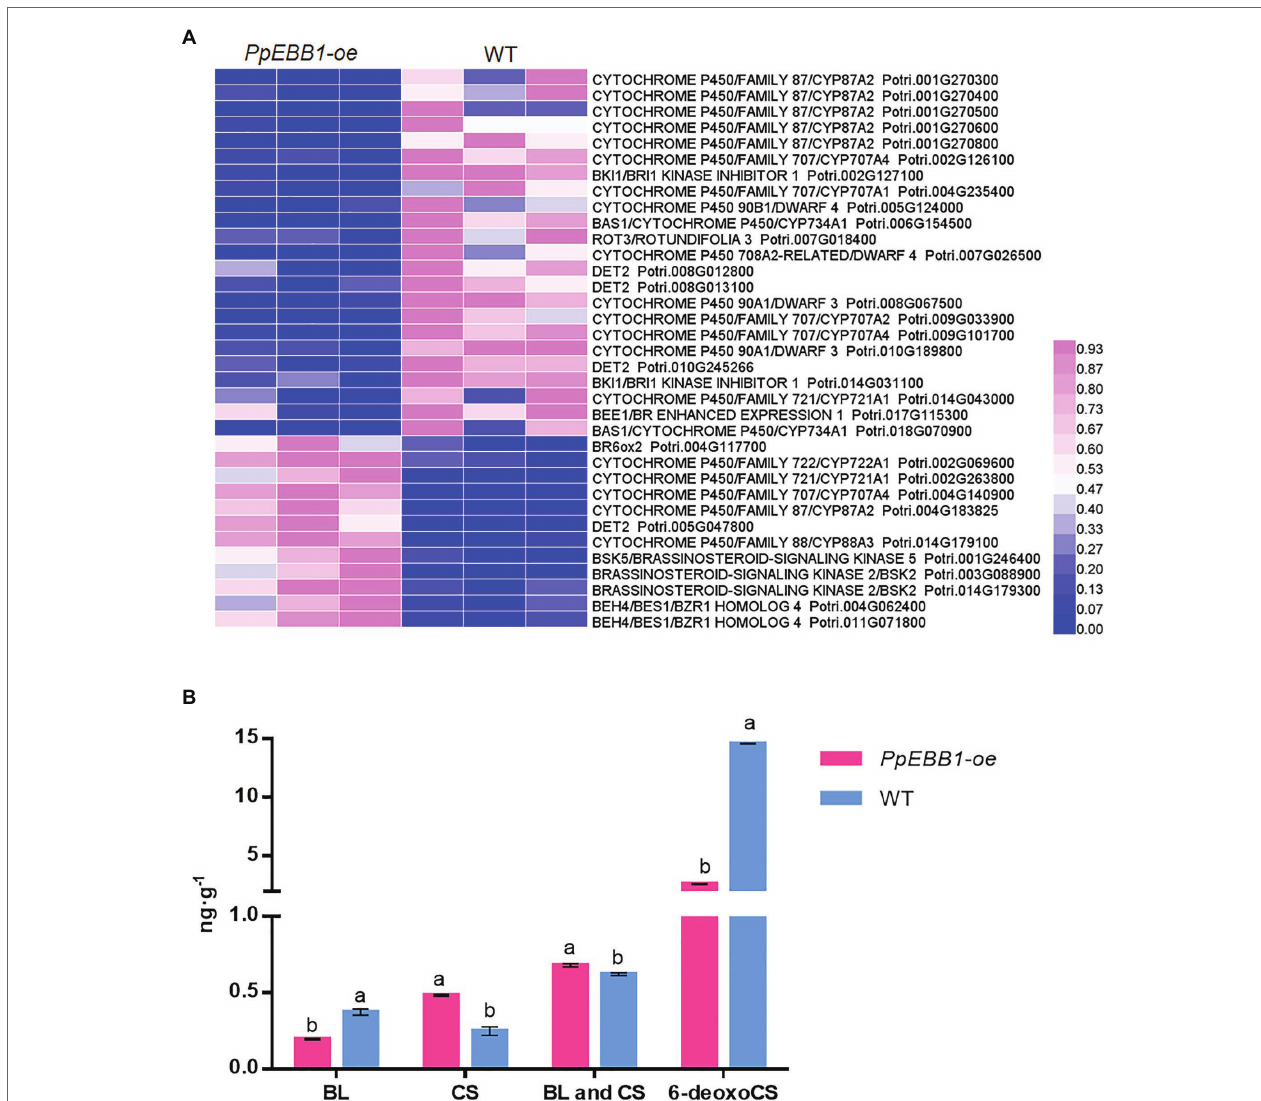
FIGURE 3 | PpEBB1 greatly influenced brassinosteroid (BR) metabolism. (A) DEGs involved in BR biosynthesis, metabolism, and signaling between PpEBB1-oe and WT. Genes with significant |log2_ratio| ≥ 1 changes between PpEBB1-oe line 29 and WT were identified as DEGs. Purple represents higher expression, while blue represents lower expression. The expression value of DEGs in transcriptomic data were processed by Min-MaxNormalization from 0 to 1, and the scale is represented in the expression level. (B) Contents of BL, CS, and 6-deoxoCS in PpEBB1-oe and WT. The values represent the means ± SDs of three replicates. Letters indicate significant differences by ANOVA followed by Duncan’s test ( p <